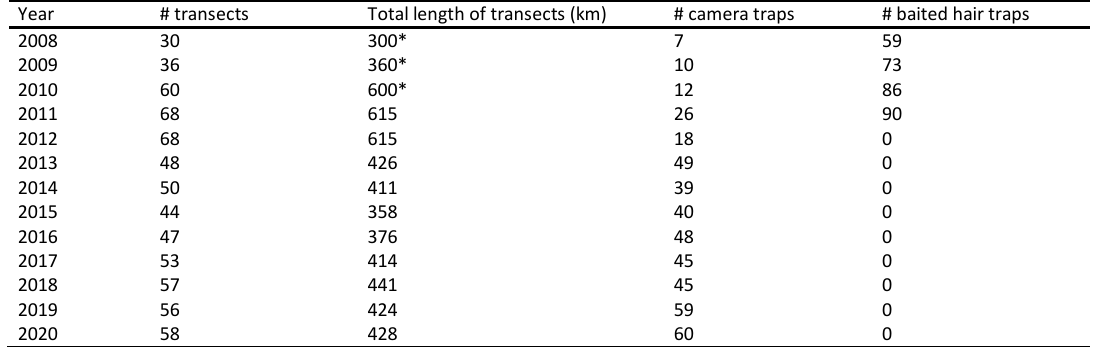
Table S1: Systematic monitoring effort in the French Pyrenees in terms of number of transects (including 6 hair traps per transect in average), total length of transects (km), number of camera traps, number of baited hair traps per year between 2008 and 2020.